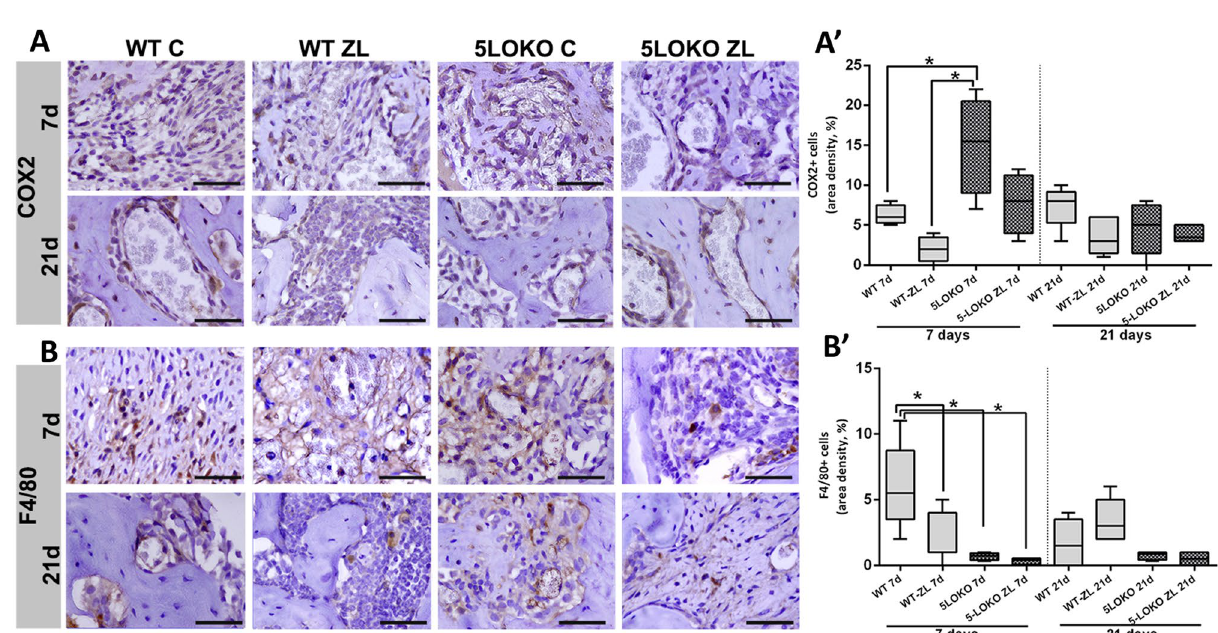
Figure 6. Immunolabeling and quantification of COX2 and F4/80 + cells at 7 and 21 days post tooth extraction in WT and 5LOKO mice, treated or not with ZL. Aged 129 Sv WT female mice received IP injections of 0.9% saline solution ( C ) or 250 μg/Kg (ZL groups) once a week, and upper right incisor were extracted at 4 week of each treatment. Mice were euthanized for maxillary bones removal after 7 days and 21 days post tooth extraction. ( A ) Representative transversal sections from the central area of alveolar sockets stained for COX2 + cells ( A ) and F4/0 + cells ( B ). Quantitative and comparative analysis of COX2 + cells ( A’ ) and F4/80 + cells ( B’ ) among groups. Scale bar: 50 µm. Quantitative results are presented with Box and whiskers (Min to Max). Symbol * indicates a statistically significant difference between groups (p < 0.05). DAB chromogen and counterstaining with Harris’